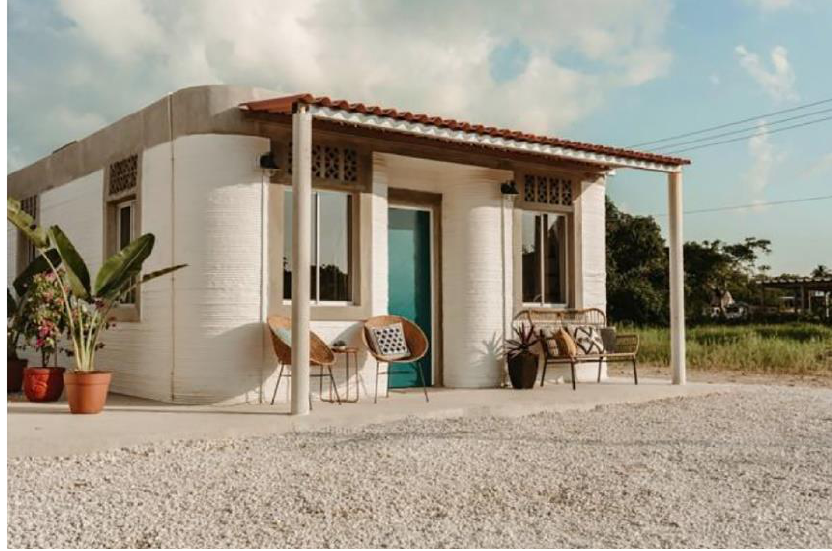
Figure 1. Example of one story 3D-printed construction (Source: [12]).